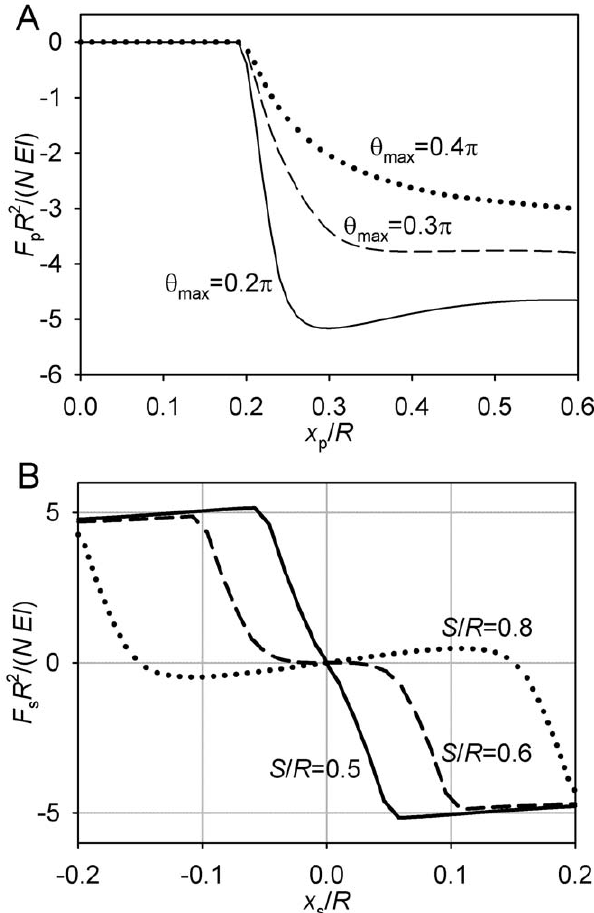
Figure 6. Transition between h max =0 and h max = p in the case of long astral microtubules. L =1.1 R . (A) Pole force function. (B) Spindle force function. S =0.3 R . The line styles correspond to values of h max as in panel A.